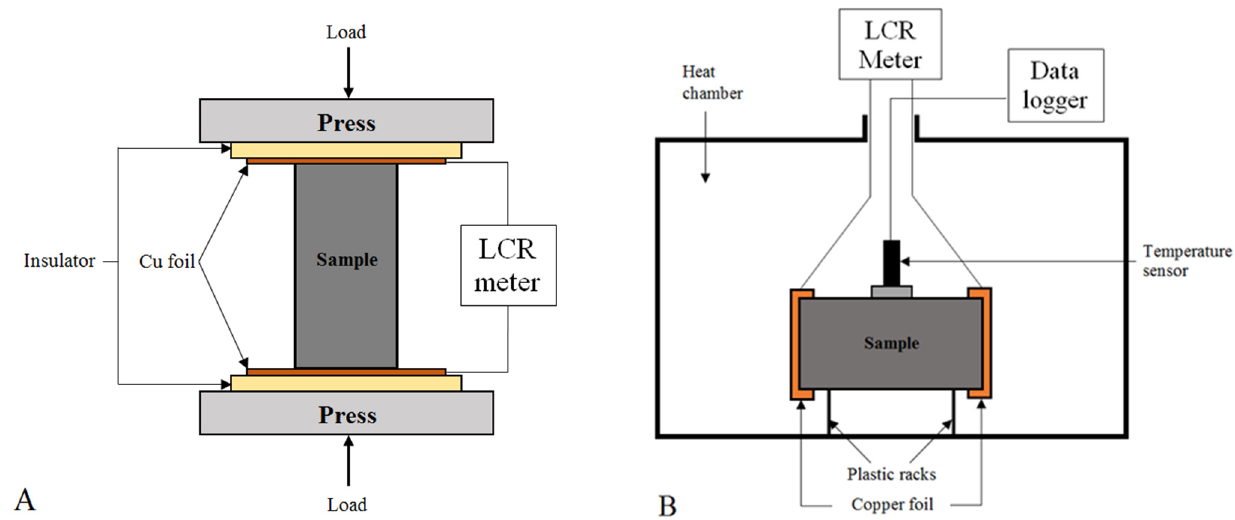
Figure 1. Experimental setup for ( A ) piezoresistive and ( B ) resistivity–temperature properties study. The resistance value was converted to resistivity using Equation